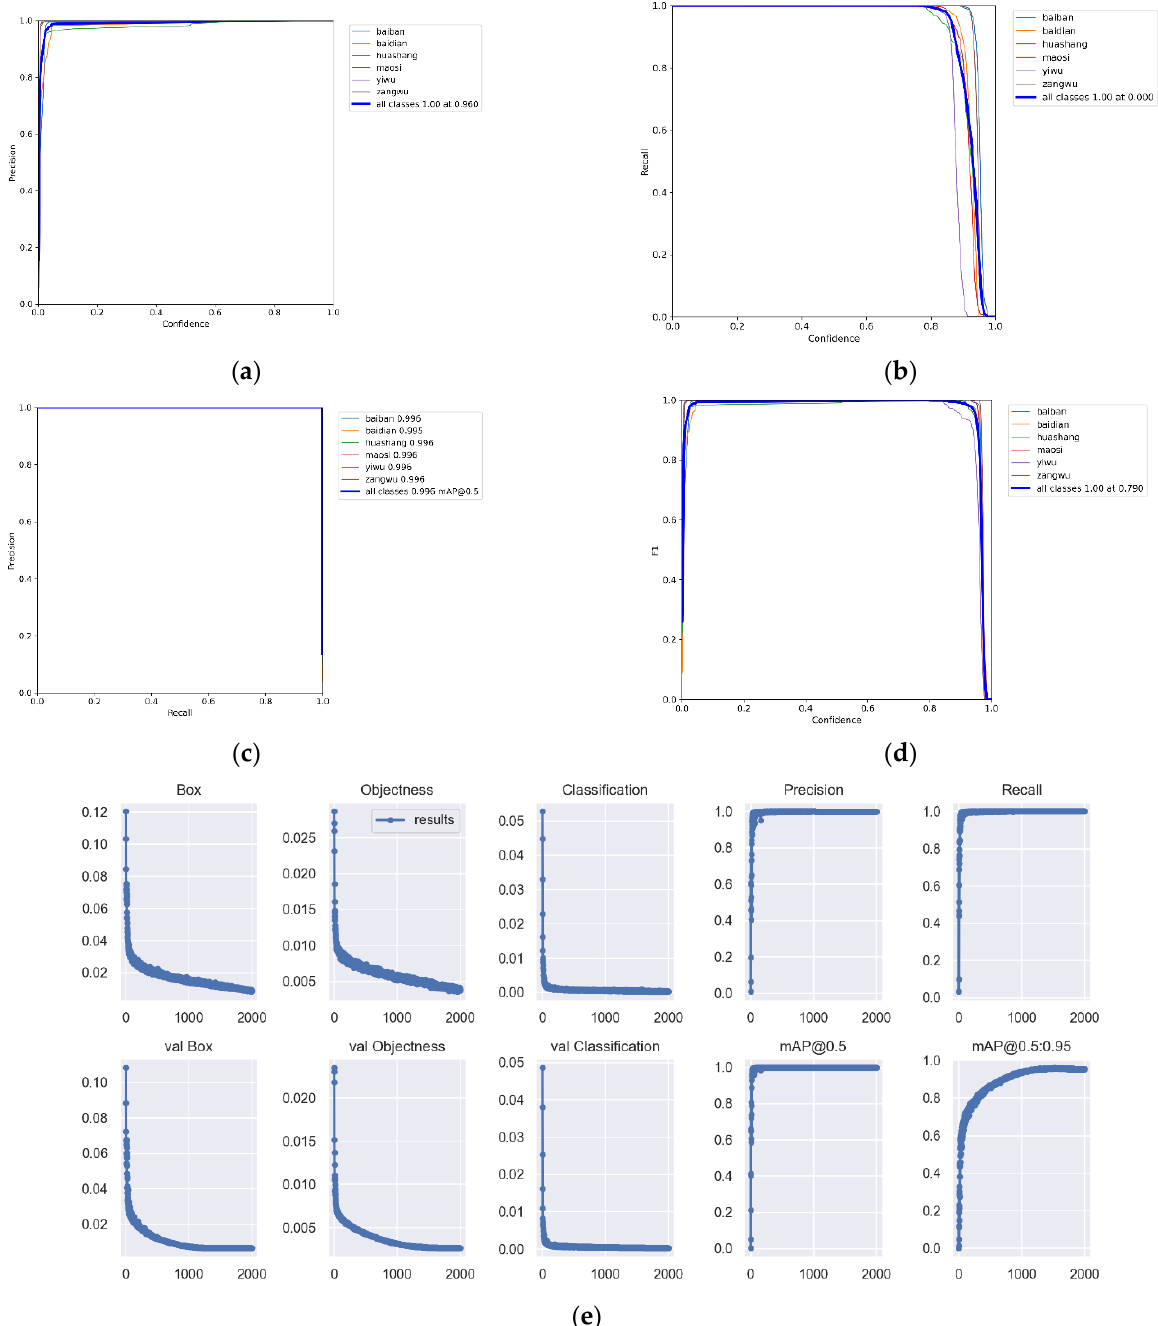
Figure 15. Performance evaluation results of the improved YOLOv5s-Small-Target model. ( a ) P (precision) curves. ( b ) R (recall) curve. ( c ) PR (Precision-recall) curve. ( d ) F1 score curve. ( e ) Improved YOLOv5s-Small-Target algorithm training results (loss function, precision, recall, and mAP transform).